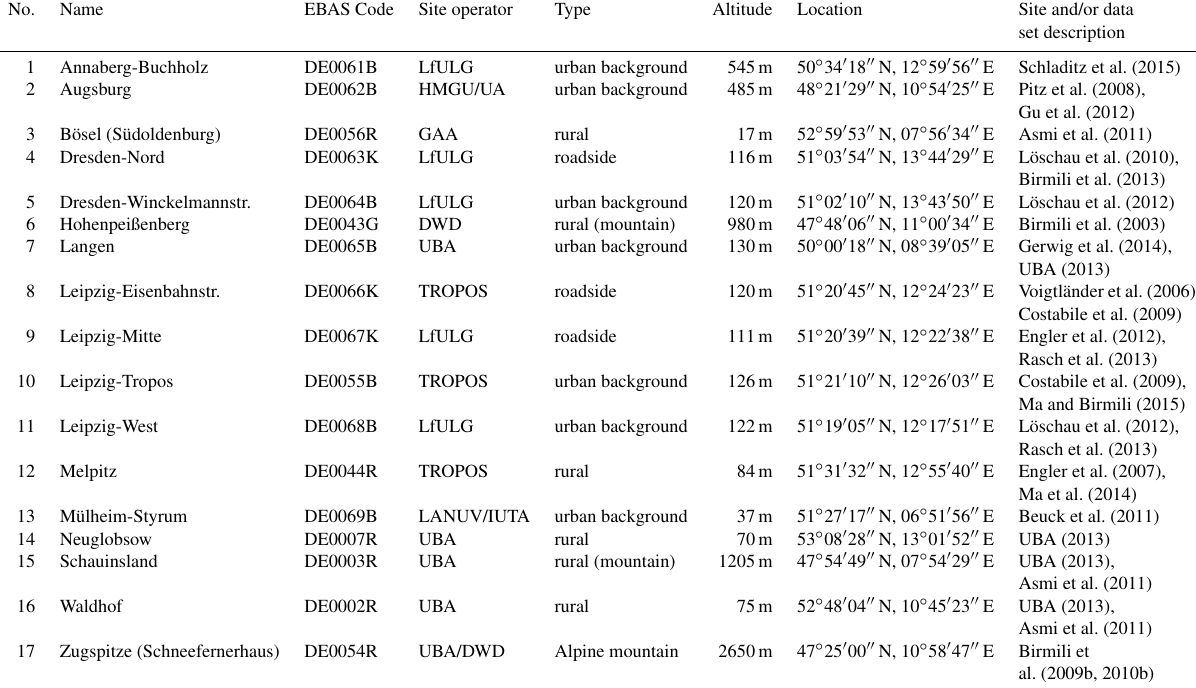
Table 1. Atmospheric measurement sites in GUAN, in alphabetic order.